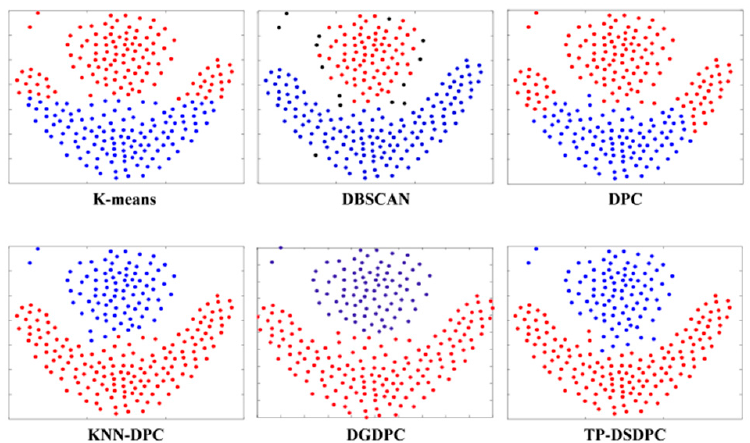
Figure 6. Clustering results on Flame.